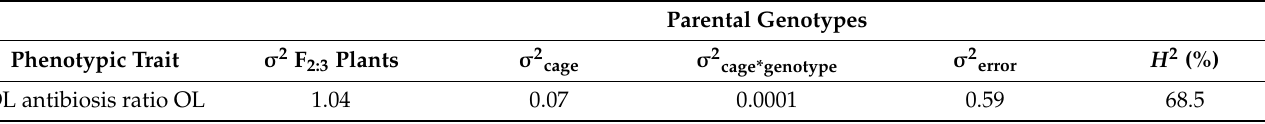
OL antibiosis ratio = (number of oviposition punctures/number of larvae), parental genotypes: Non-segregant genotypes (susceptible and resistant parents). H 2 : Broad sense heritability, H 2 = (( σ 2 F2:3 − σ 2 e )/ σ 2 F2:3 ) × 100, where σ 2 F2:3 is the phenotypic variance of the F 2:3 families, and σ 2 e = ( σ 2 cage + σ 2 cage*genotype + σ 2 error )/2 is the variance of environmental